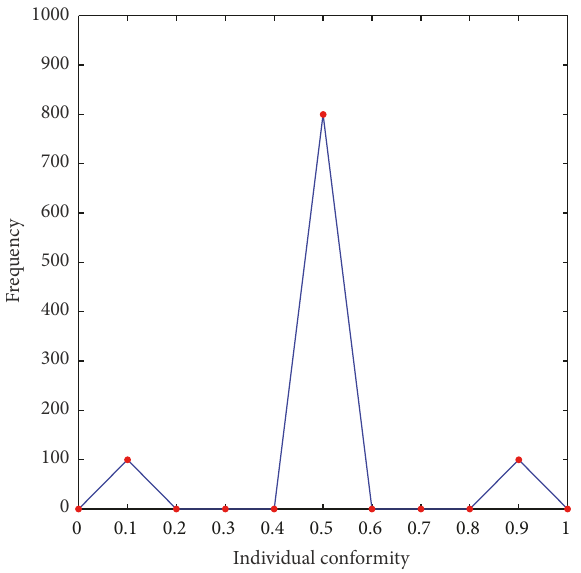
Figure 1: Individual conformity distribution. Figure 2: Individual public authority